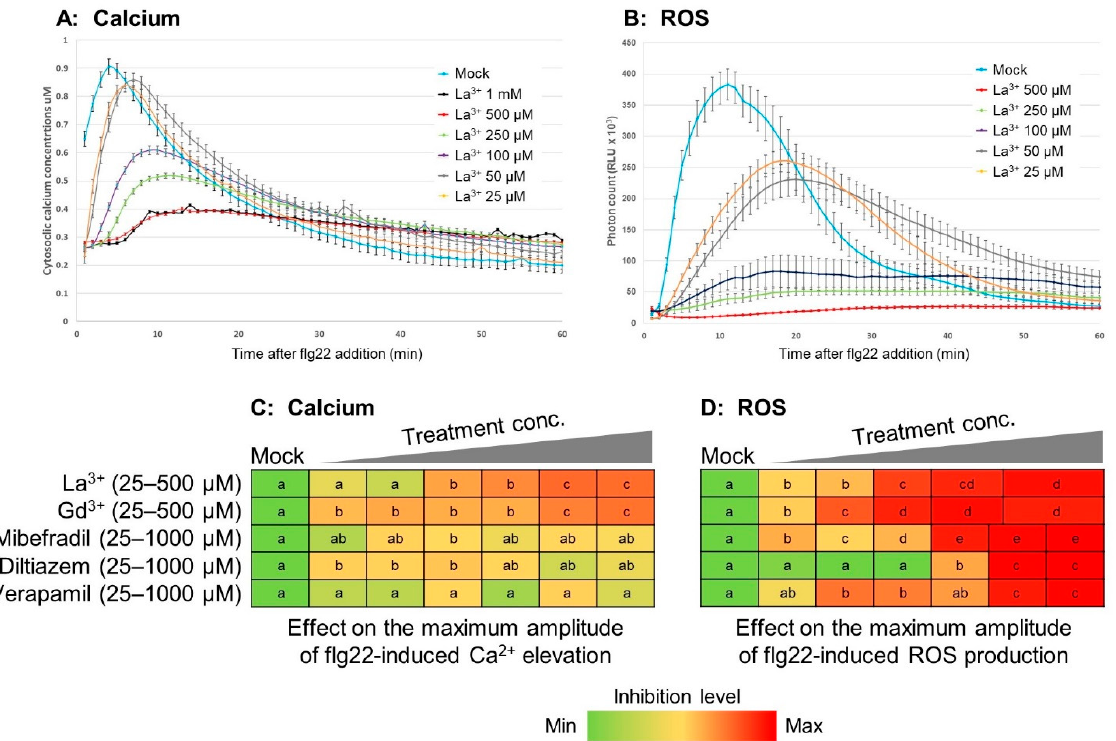
Figure 1. Effects of calcium manipulation on apoplastic ROS signaling. Line graphs show effect of the calcium channel blocker La 3+ on flg22-induced cytosolic calcium signature ( A ) and flg22-induced apoplastic ROS signature ( B ). Heatmaps show the inhibitory effect of pharmacological agents on the maximum amplitude of flg22-induced cytosolic calcium ele- vation ( C ) and flg22-induced apoplastic ROS production ( D ). Leaf discs were preincubated for 30 min with general calcium channel blockers La 3+ and Gd 3+ . (25–500 µM), the VDCC specific inhibitors mibefradil, diltiazem, and Verapamil (25–1000 µM) prior to flg22 addition. Colors indicate the lowest level of inhibition as green and the highest level of inhibition as red. Different letters in the same row indicate statistically significant differences at p < 0.05. The data obtained from the maximum amplitude in each treatment were analyzed using ANOVA followed by the Tukey – Kramer multiple compari- son test.